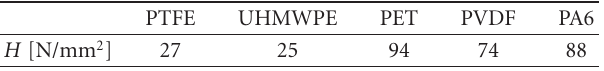
Table 1: Hardness of the tested polymers measured according to ISO 2039-1 ball indentation method for